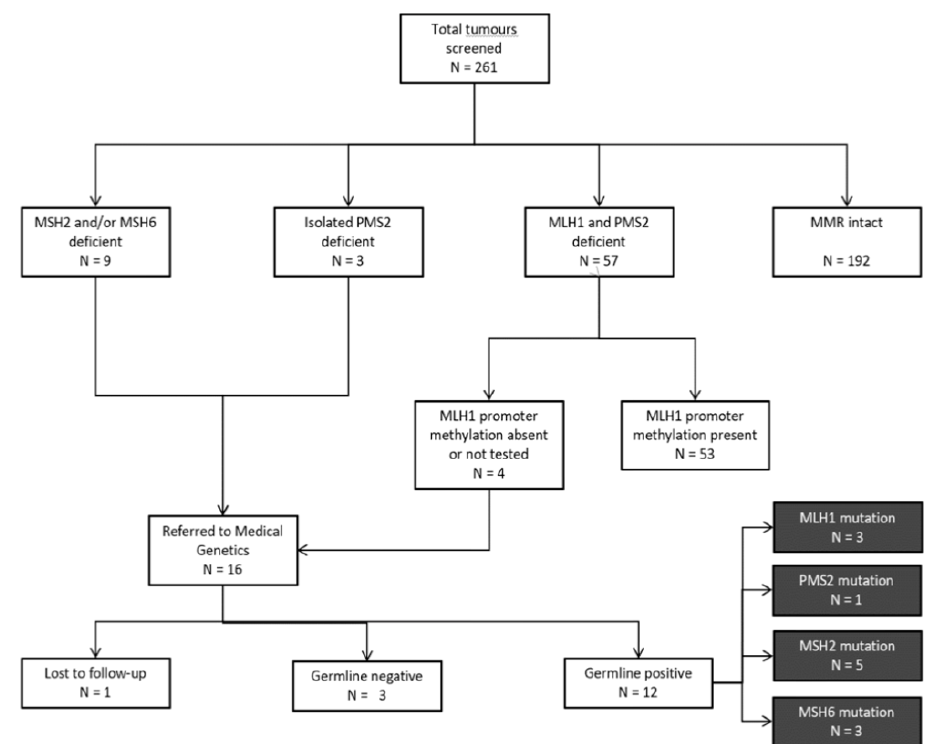
Figure 1. Flow diagram of the analytical strategy and main results of this study. Note: one additional PMS2 germline mutation was identified in a patient that was screen-negative. This patient was not included in calculations of screen efficacy but was included in calculations of estimated germline mutation rate among unselected endometrial cancer patients.